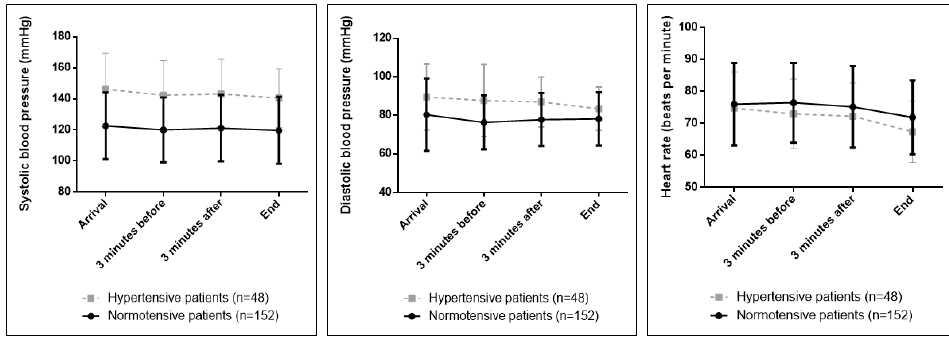
Figure 2. Evolution of physiological parameters in hypertensives and normotensives.